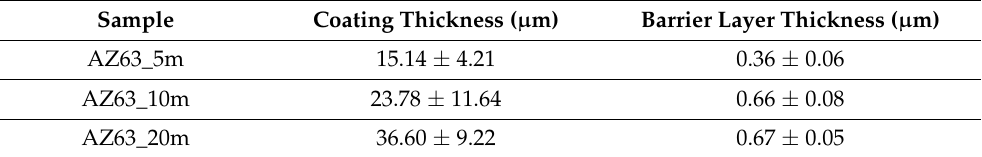
Table 5. Coating and barrier layer mean thickness.